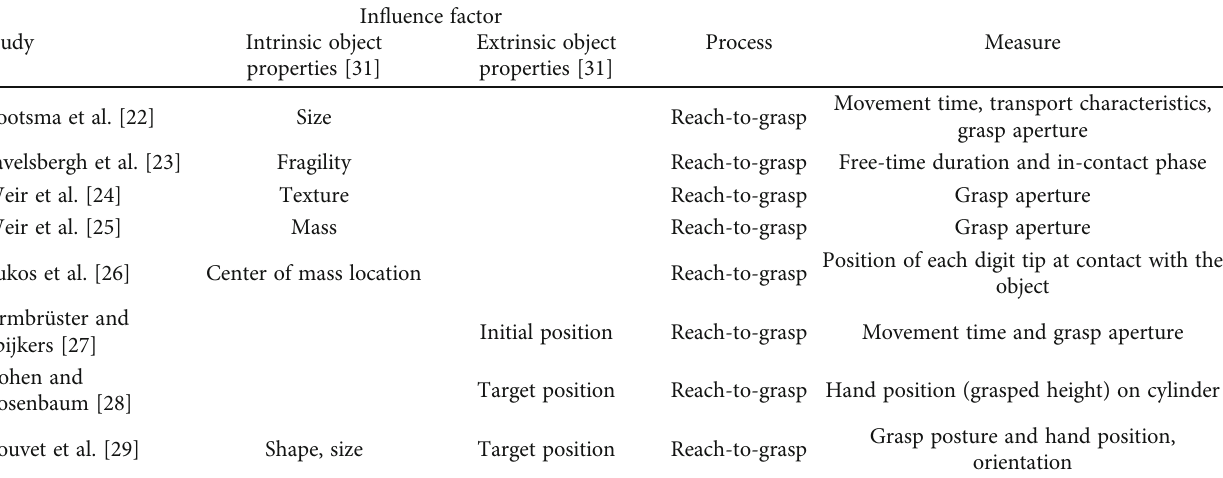
Table 2: Summary of human grasp kinematic